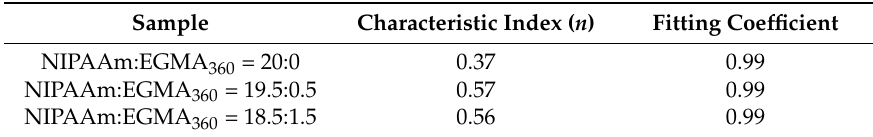
Table 2. Swelling kinetic parameters of alginate-Ca 2+ /P(NIPAAm- co -EGMA 360 ) hydrogels. Sample Characteristic Index ( n ) Fitting Coefficient